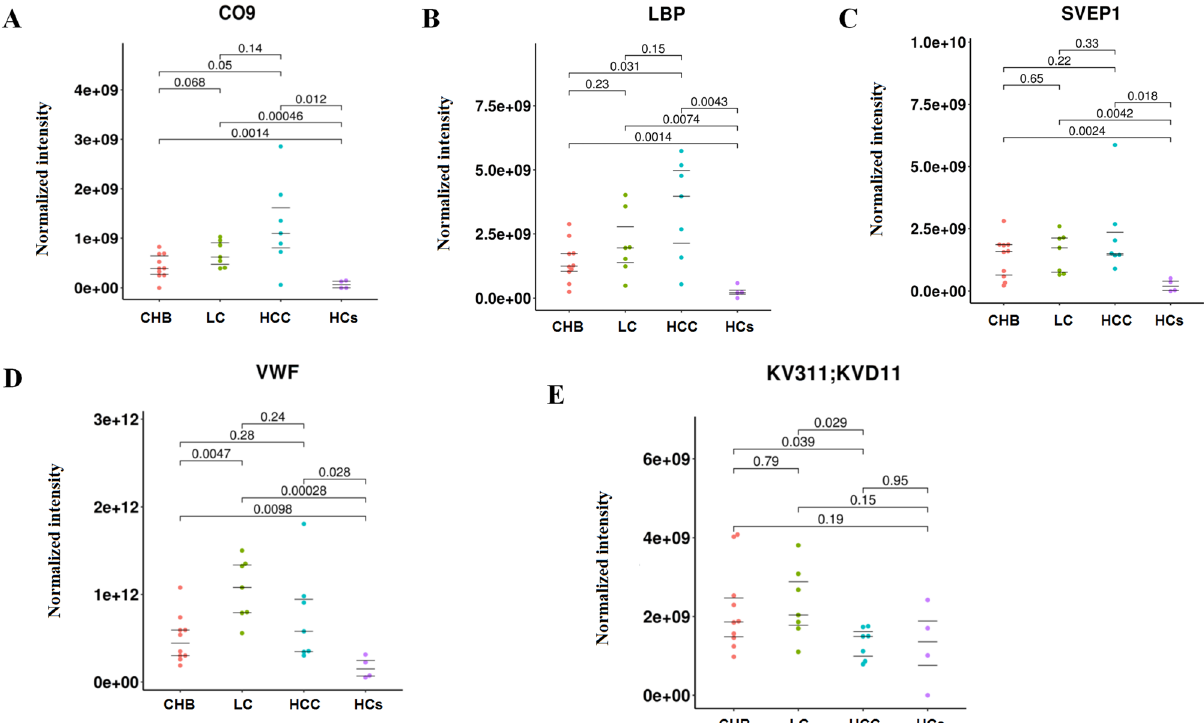
Figure 4. Comparison of the differentially expressed proteins, namely CO9, LBP, SVEP1, VWF and KV311, between the chronic hepatitis B (CHB), liver cirrhosis (LC), hepatocellular carcinoma (HCC), and healthy control (HC) groups ( A – E ). The main R package to draw the beeswarm plots was and HCs. The highest number of differentially expressed proteins was observed between LC and HCs, whereas the lowest was observed between CHB and HCC. Exosomes have a rich and complex protein composition, which may be involved in regulating a variety of biological processes. Therefore, exosomes may be considered as a new, specific, sensitive, and non-invasive diagnostic marker for HBV-related liver disease based on the differentially